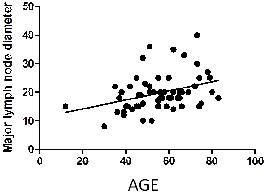
Correlation between the size of the major lymph node diameter and age. Spearman r 0.3475; 95% confidence interval 0.1772 to 0.4975; P value (two-tailed) <0.0001; P value summary ****.